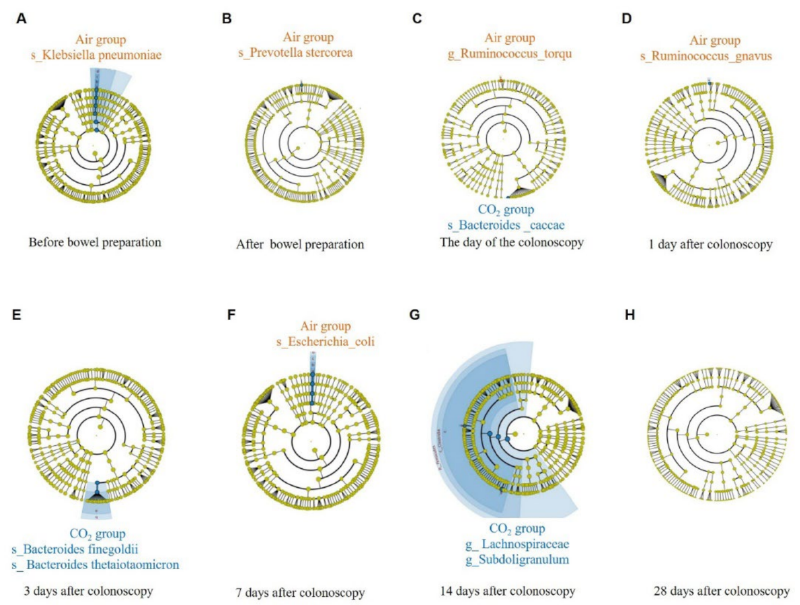
Figure 5. Differences in intestinal bacteria after colonoscopy. Cladogram of LEfSe analysis showed that within 14 days after colonoscopy, Bacteroides caccae , Bacteroides finegoldii , Bacteroides thetaio- taomicron , Subdoligranulum and Lachnospiraceae in the CO 2 group were significantly higher; On the contrary, Escherichia coli , Ruminococcus torques and Ruminococcus guavus in the air group were significantly higher. CO 2 , carbon